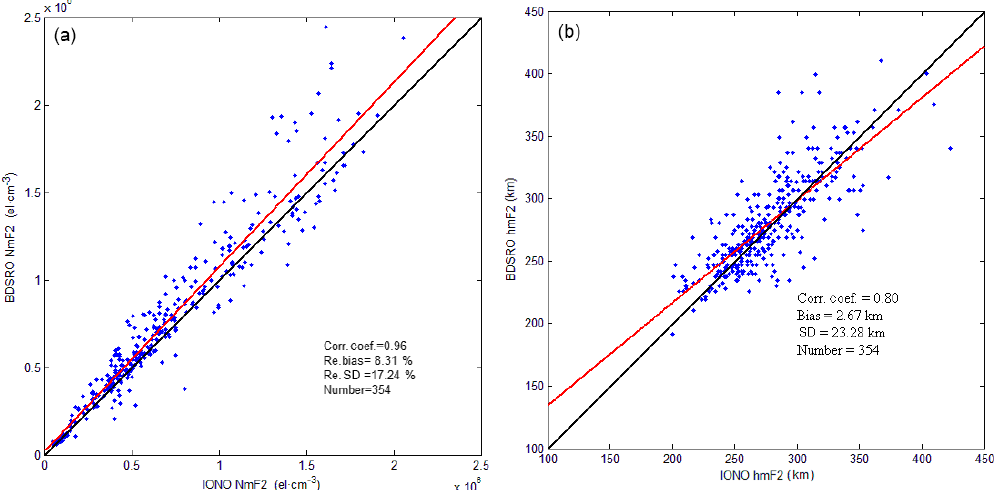
Figure 5. Same as Fig. 4, but for GNOS Beidou navigation system (BDS). Comparison of NmF2 and hmF2 measurements from GNOS BDS occultation and ionosondes. Panel (a) shows a NmF2 linear regression fit between the two sets of measurements; panel (b) shows a hmF2 linear regression fit between the two sets of